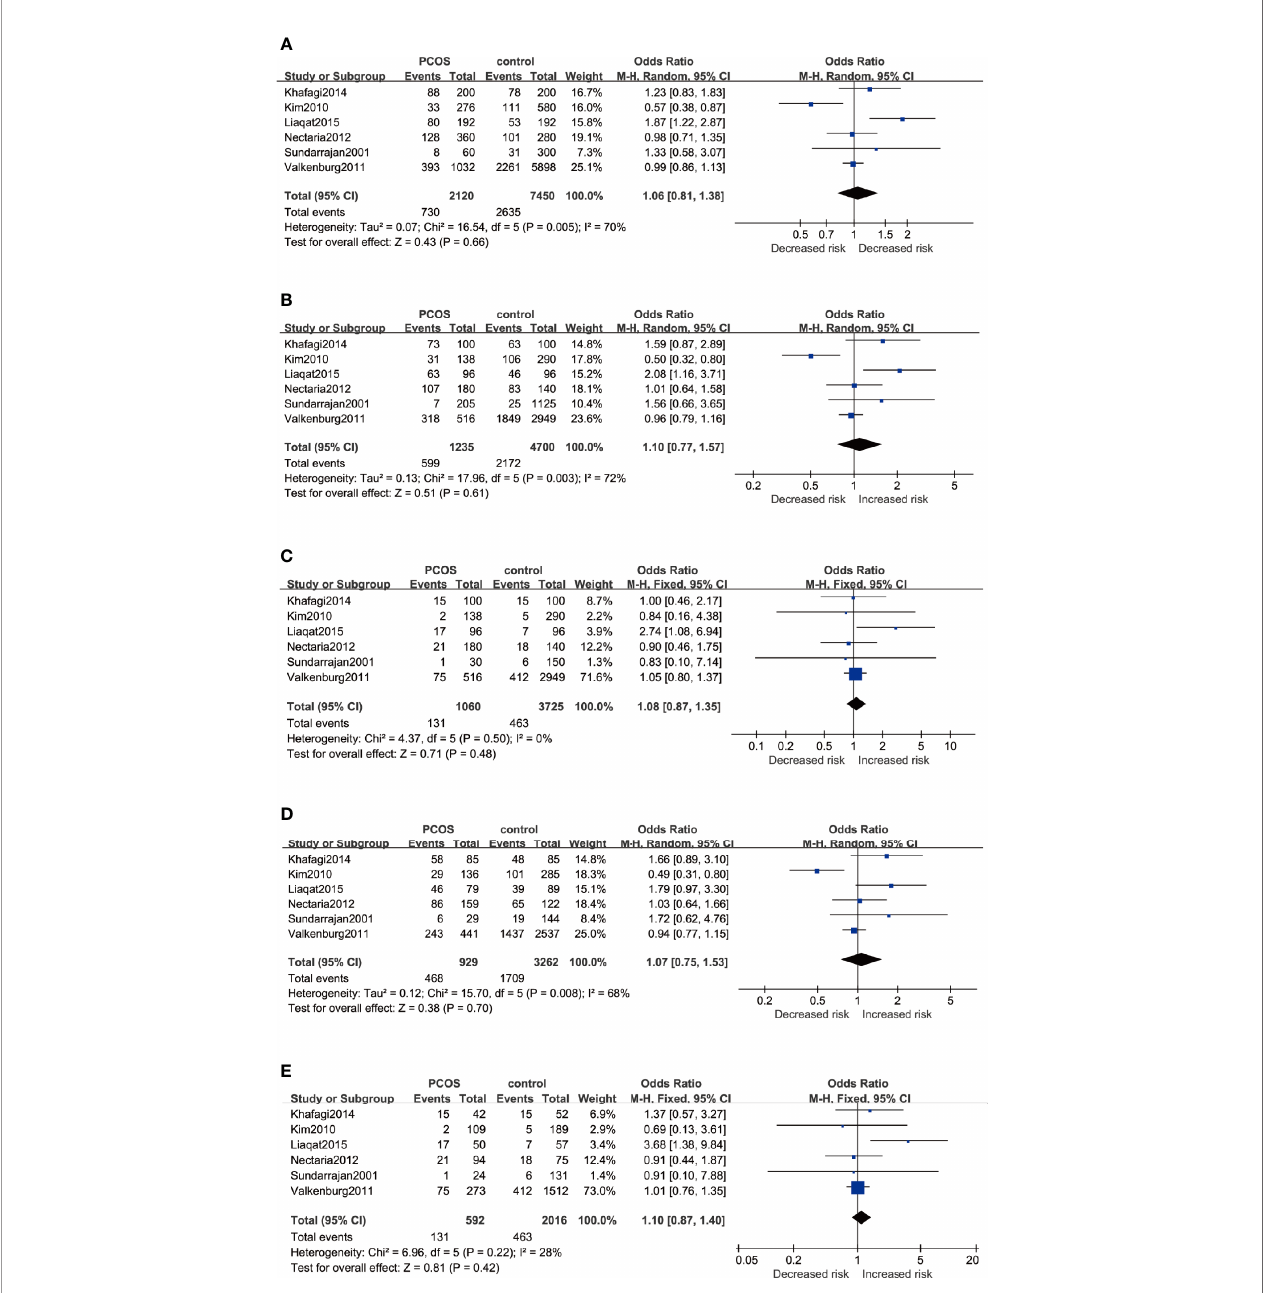
FIGURE 4 | Forest plots of the association between the ESR2 rs4986938 gene and risk of PCOS using different genetic models in overall analysis: (A) Allele model (A versus G), (B) Dominant model (AA+GA versus GG), (C) Recessive model (AA versus GG+GA), (D) Heterozygote model (GA versus GG), and (E) Homozygote model (AA versus GG). In each model, solid squares represent the OR, horizontal lines represent 95%CI, and diamond represents the pooled OR and 95%CI. OR, odds ratios; 95% CI, 95% con fi dence intervals; I 2 , inconsistency